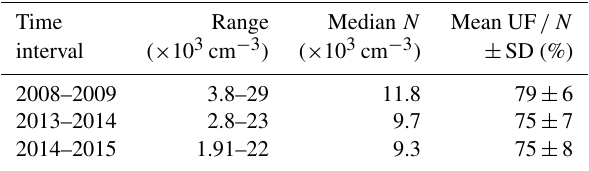
Table 1. Ranges and medians of daily total particle number concen- trations ( N ) and mean contributions of ultrafine (UF) particles to N with standard deviations (SD) in central Budapest for 1-year-long